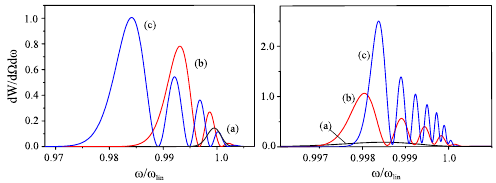
FIG. 1. (left) d 2 W as a function of !=! lin with increasing laser d!d (cid:1) parameter: (a) a 0 ¼ 0 : 015 ( W ¼ 0 : 05 J ), (b) a 0 ¼ 0 : 0466 ( W ¼ 0 : 066 ( W ¼ 1 J ). (right) d 2 W 0 : 5 J ), (c) a as a function of 0 ¼ d!d (cid:1) !=! lin with increasing laser duration (cid:3) (cid:6) and constant value of a 0 ¼ 0 : 0722 : (a) (cid:3) (cid:6) ¼ 0 : 25 ps ( W ¼ 0 : 2 J , (cid:8) ¼ 1 : 5 (cid:3) 10 (cid:2) 3 ), (b) (cid:3) (cid:6) ¼ 1 : 5 ps ( W ¼ 1 : 2 J , (cid:8) ¼ 2 : 5 (cid:3) 10 (cid:2) 4 ), (c) (cid:3) (cid:6) ¼ 3 ps ( W ¼ 2 : 4 J , (cid:8) ¼ 1 : 25 (cid:3) 10 (cid:2) 4 ). Other parameters: (cid:1) ð 0 Þ ¼ 200 , = 2 (cid:3) (cid:1) 6 (cid:3) 10 14 s (cid:2) 1 w 0 ¼ 27 (cid:10) m , ! L